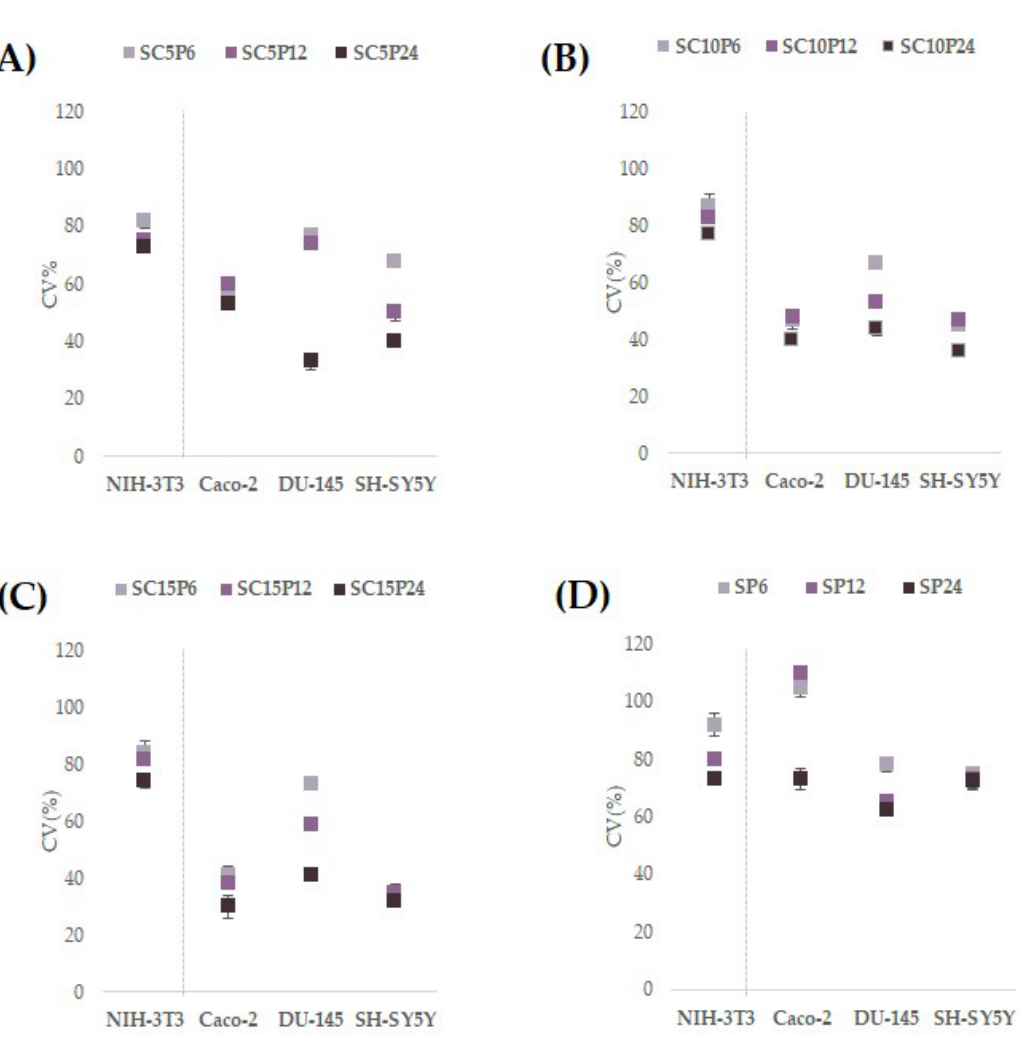
Figure 6. Cell Viability (CV%) of NIH-3T3, Caco-2, DU-145, and SH-SY5Y cell lines after 48 (cid:3031) h exposure time with SCP hybrids ( A – C ) and SP hybrids ( D ). Values are reported as mea n ± SD of three independent measurements carried out on three samples of each synthetized material at 1 (cid:3031) mg dose.